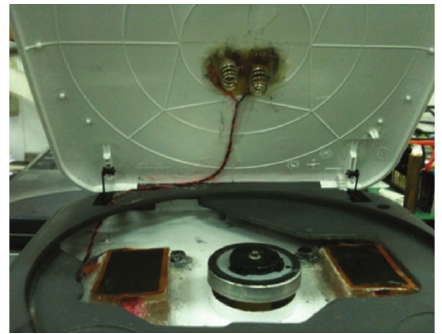
Figure 8: Electrical contacts to supply electricity to the test disk.